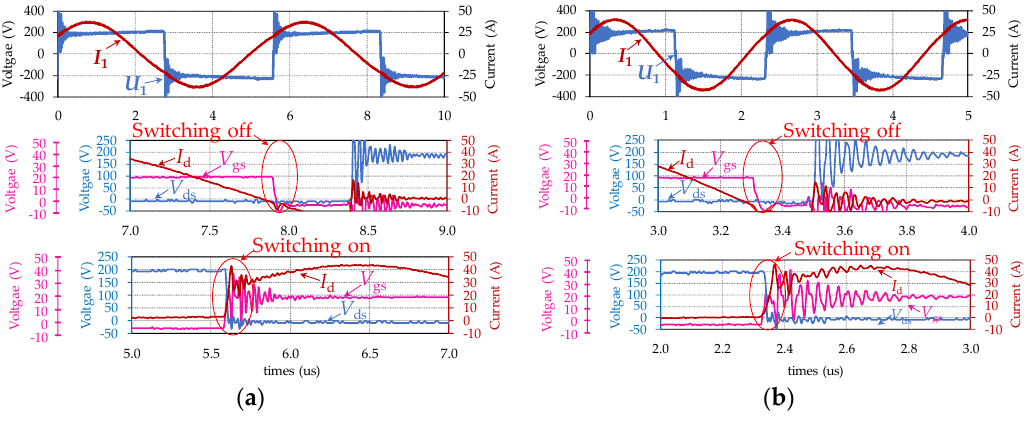
Figure 11. WPT system of higher resonant frequency with soft switching: ( a ) 180 kHz@200 kHz y; ( b ) 450 kHz@500 kHz.